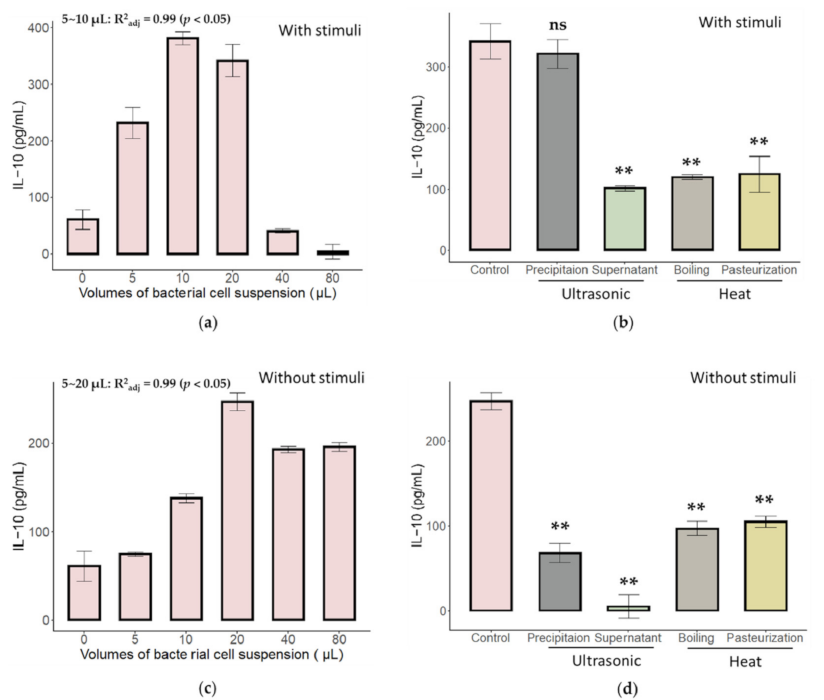
Figure 1. Characteristics of B. bifidum and C. butyricum in the in vitro MLN model. Dose-dependent response for B. bifidum ( a ) and C. butyricum ( c ). Adjust R square was calculated within the linear range. The influence of different treatments of bacterial cells of B. bifidum ( b ) and C. butyricum ( d ) on the immune response. ** Indicated a significant difference ( p < 0.01) when compared to the control group using a t -test. In a commonly used co-culture system (20 µ L of bacterial cells co-cultured with 180 µ L of MLN cells), the ratio of these cells was 10:1 with 2 × 10 5 MLN cells. All tests were replicated three times. ns: no